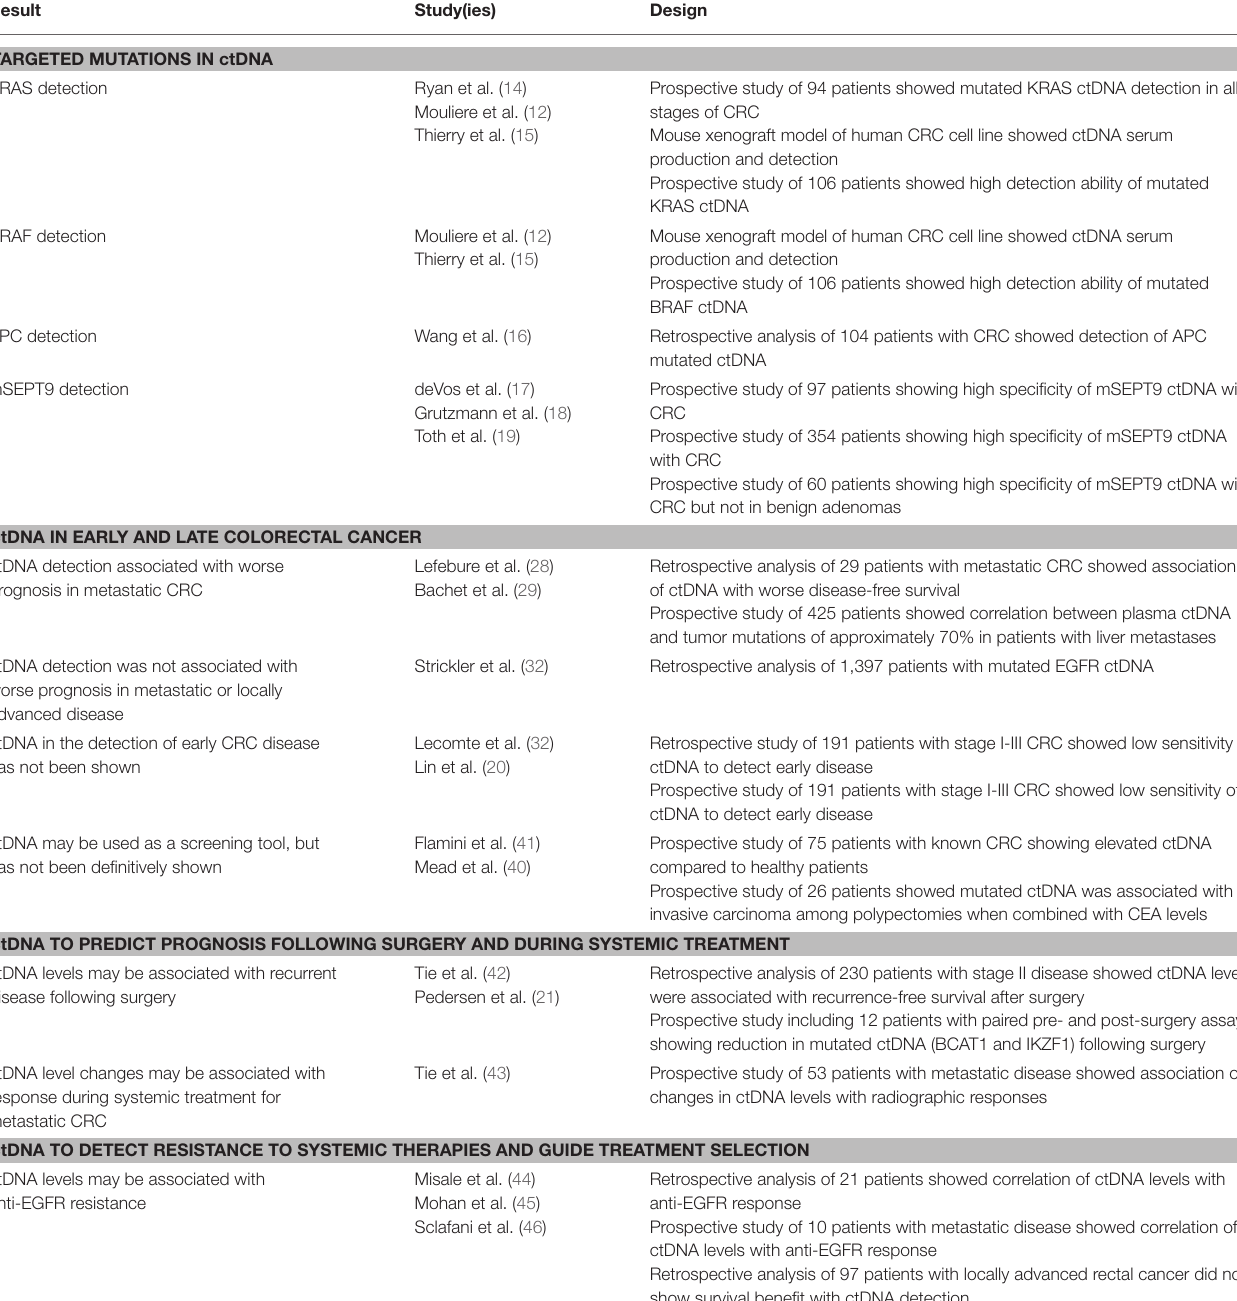
TABLE 1 | Summary of studies involving ctDNA and colorectal cancer, presented by topic subheading within the